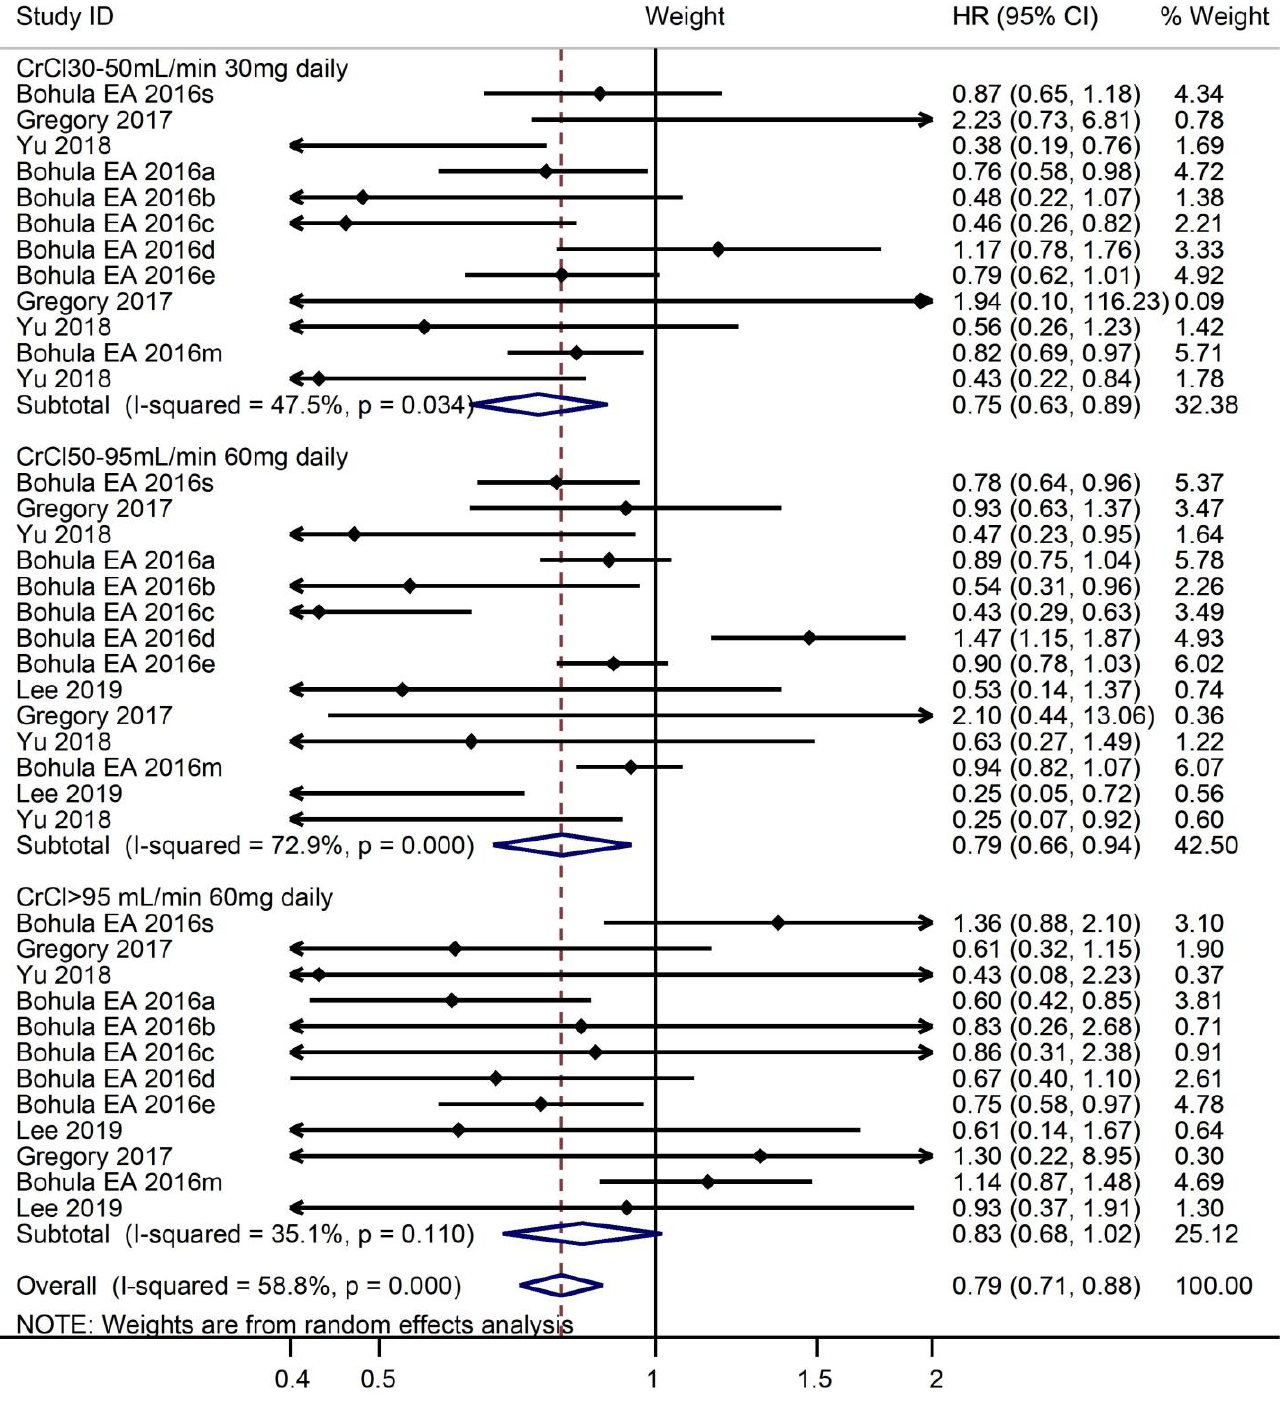
Figure 8. Primary efficacy, safety, and net clinical outcome end points by prespecified CrCl sub-groups.